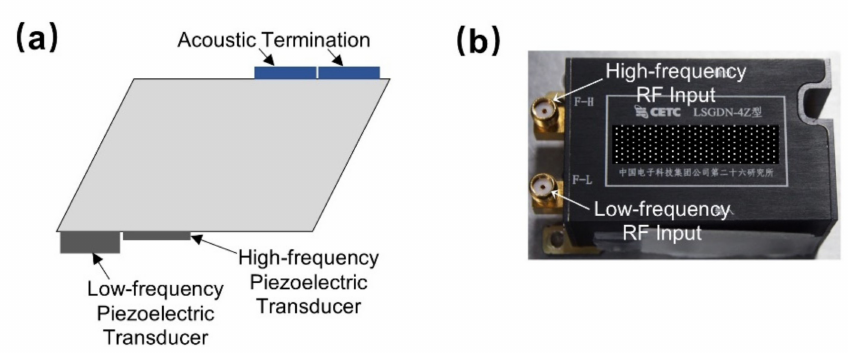
Figure 5. AOTF used on VNIS. ( a ) Main structure of the AOTF; ( b ) The physical object of